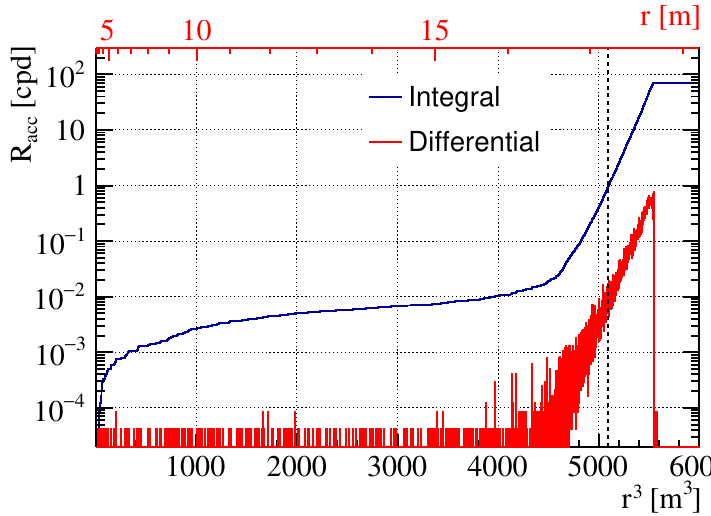
Figure 10. The differential (integral) distribution of the accidental rate as a function of radius with the default selection cuts of section 3.1 is shown as the red (blue) histogram. The default FV radius cut is shown as the dashed